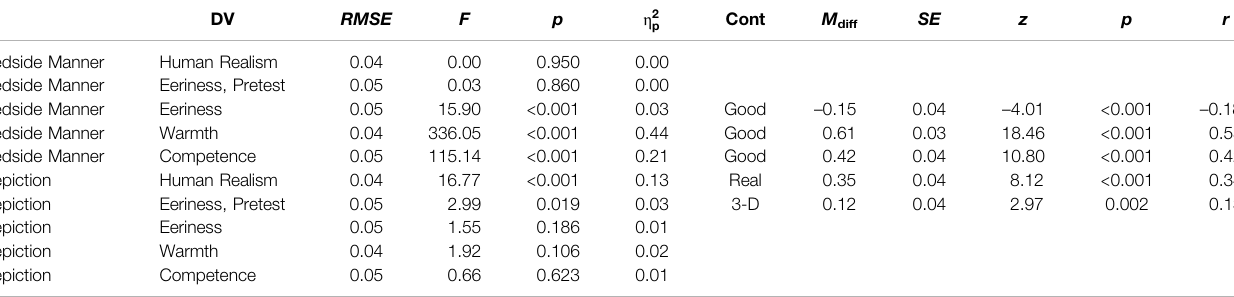
TABLE 2 | Mixed-effects model of bedside manner and depiction on Human Realism, pretest Eeriness, Eeriness, Warmth, and Competence with planned contrasts.